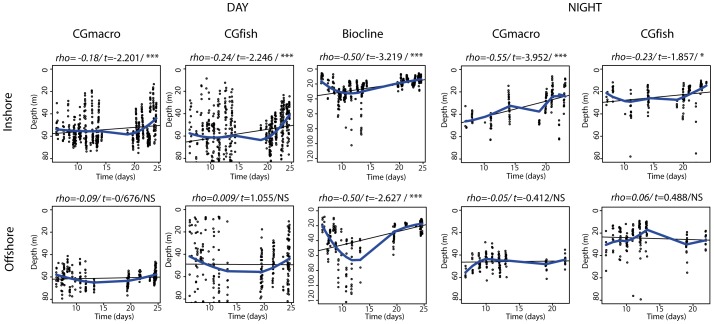
Day-night temporal correlations of macrozooplankton (CGmacro and biocline) and fish (CGfish).Analyses were done according to inshore and offshore ecological domains. Scatter plots include a linear fit (black solid line) and loess smoothing (blue solid line) to illustrate the sign of the correlation.